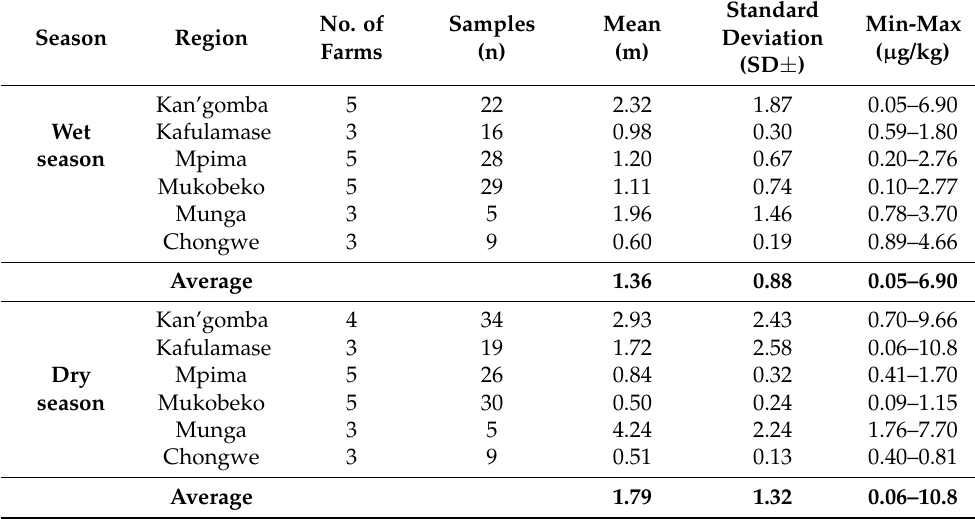
Table 1. Summary of mean lead concentrations ( µ g/kg-wt./wt.).